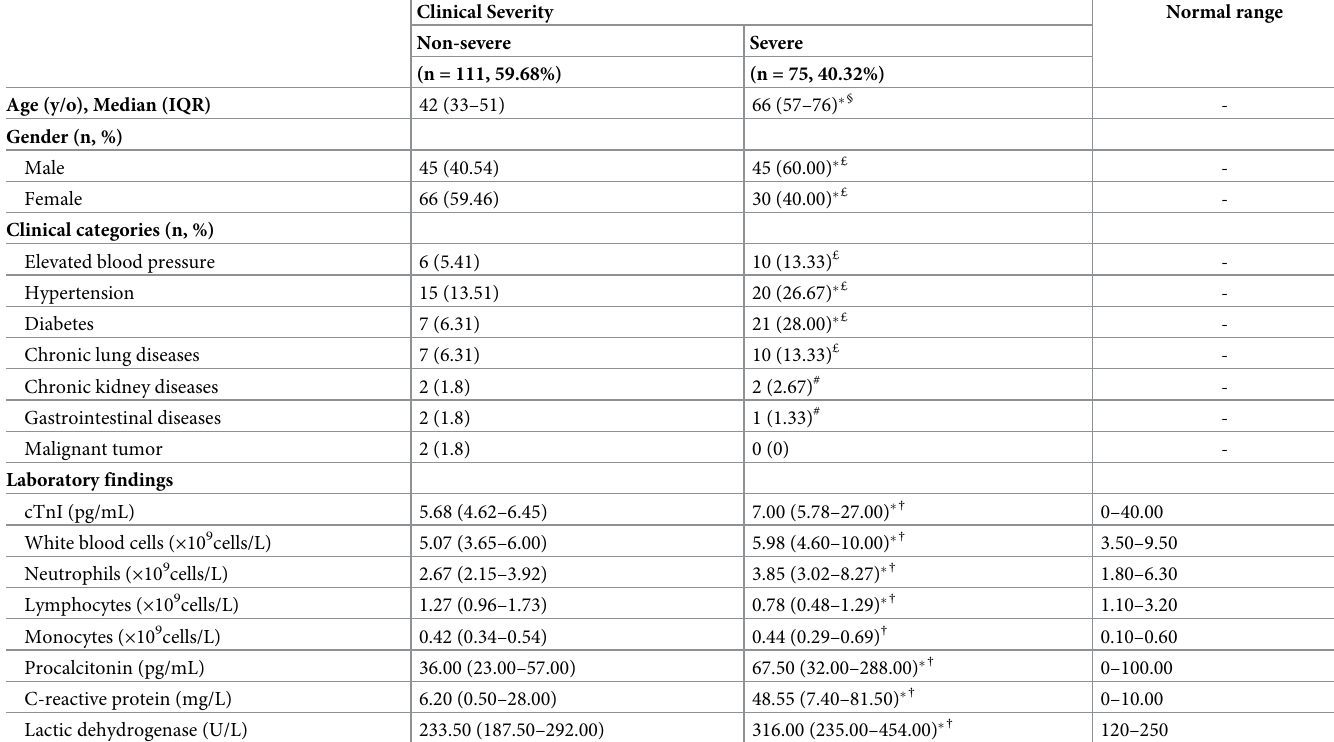
Table 7. Clinical characteristics of severe and non-severe COVID-19